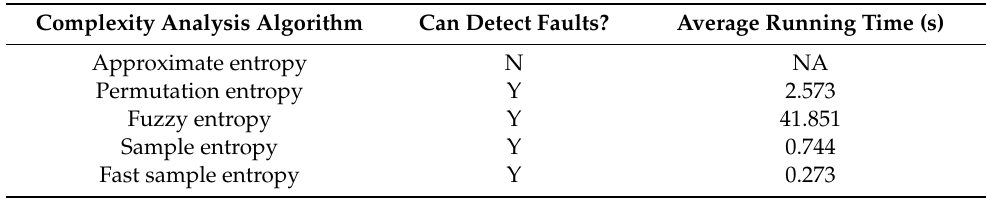
Table 4. The average running time of several complexity analysis algorithms applied in rolling bearing fault